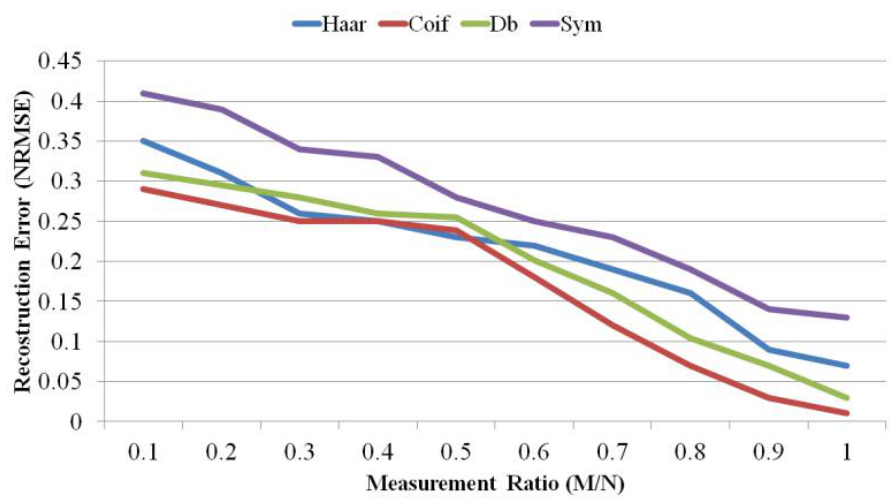
Figure 11. Comparing Haar, Symlet, Coiflet, and Daubichi transforms in terms of reconstruction